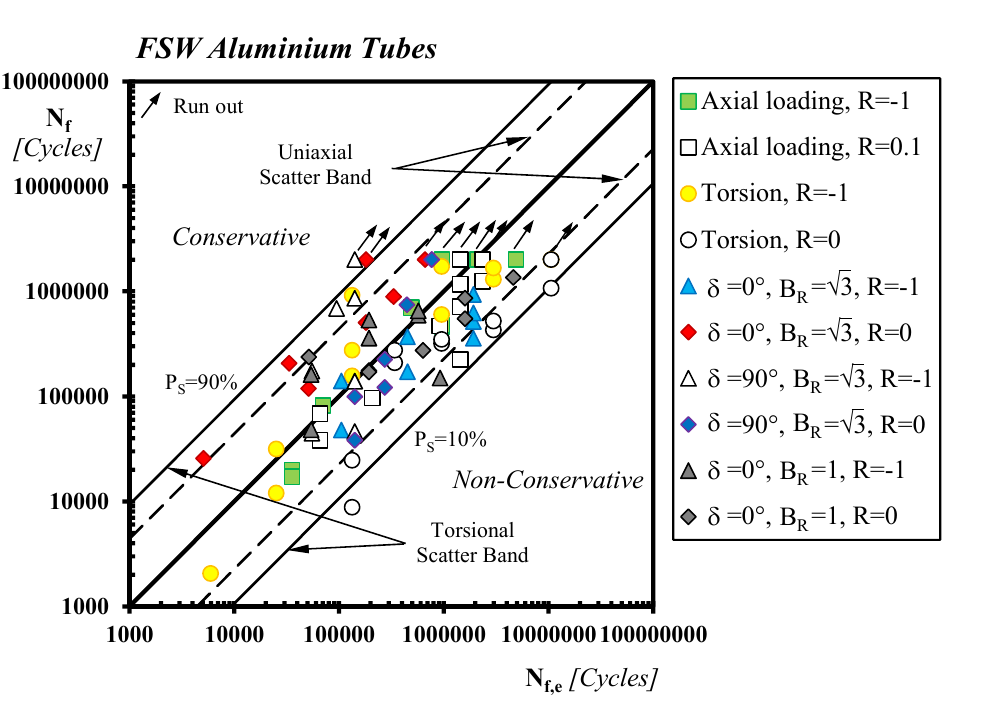
V ALIDATION BY EXPERIMENTAL